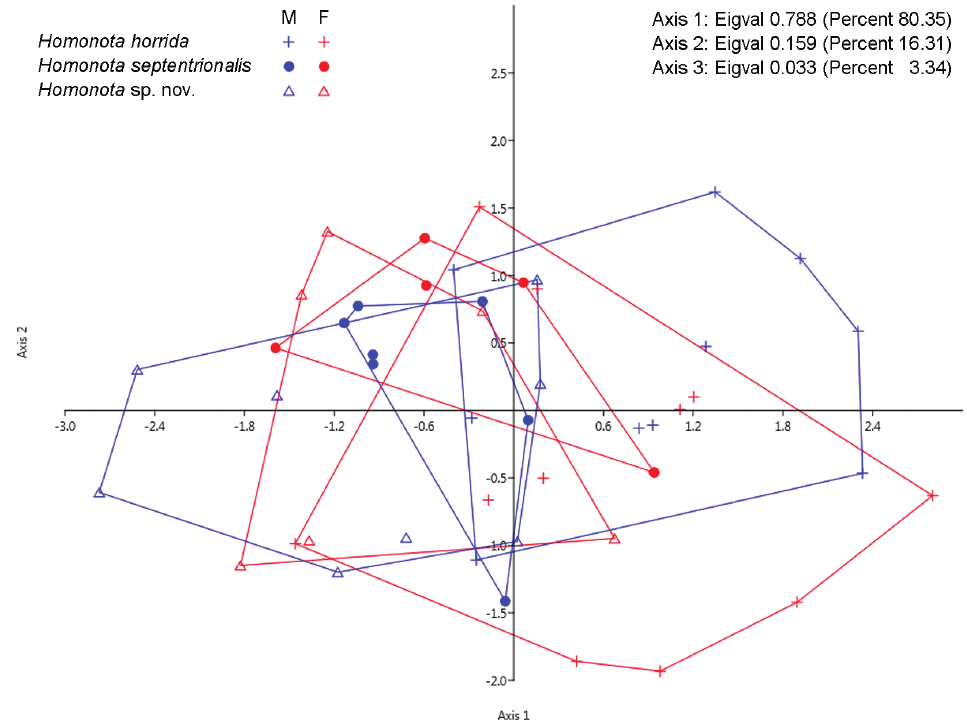
Figure 3. Discriminant Function Analysis scatter plot of individual scores for the three most informative axes for discrete variables of Homonota horrida , H. septentrionalis , and Homonota sp. n. Eigval: Eigenvalues. M: males. F: